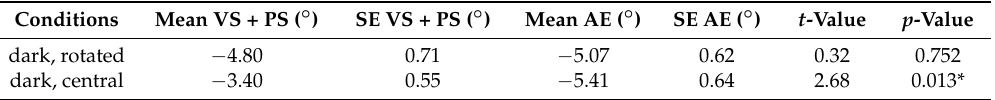
Table 3. The sum of visual straight ahead (VS; gaze direction) and proprioceptive straight ahead (PS) after prism adaptation vs. aftereffect (AE), in the dark with prisms on. Two-sided paired t -test. Conditions Mean VS + PS (°) SE VS + PS (°) Mean AE (°) SE AE (°) t -Value p -Value dark, rotated − 4.80 0.71 − 5.07 0.62 0.32 0.752 dark, central − 3.40 0.55 − 5.41 0.64 2.68 0.013*